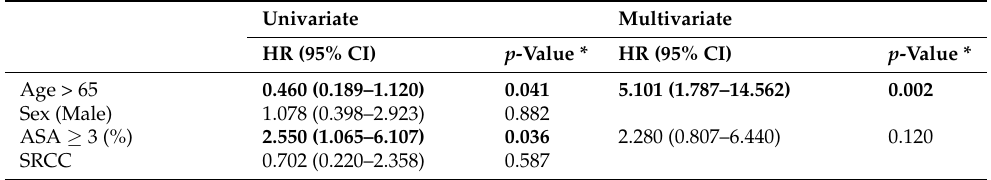
Table 4. Logistic regression analysis for major